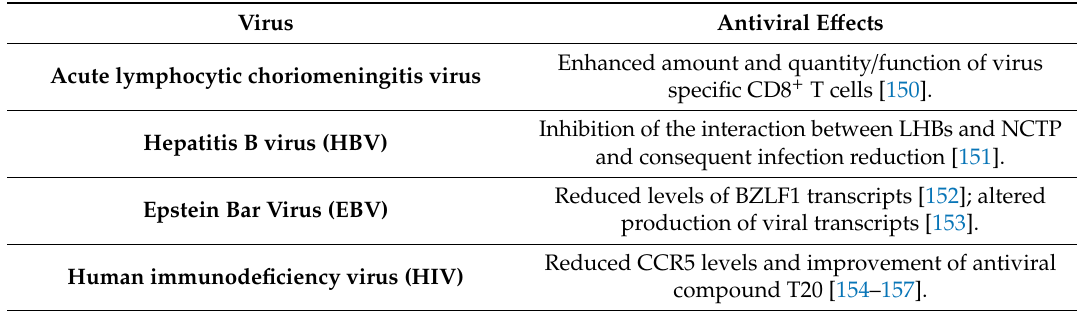
Table 2. Antiviral e ff ects of rapamycin on several viruses. Virus Antiviral E ff ects Enhanced amount and quantity / function of virus Acute lymphocytic choriomeningitis virus specific CD8 + T cells [150]. Inhibition of the interaction between LHBs and Hepatitis B virus (HBV)